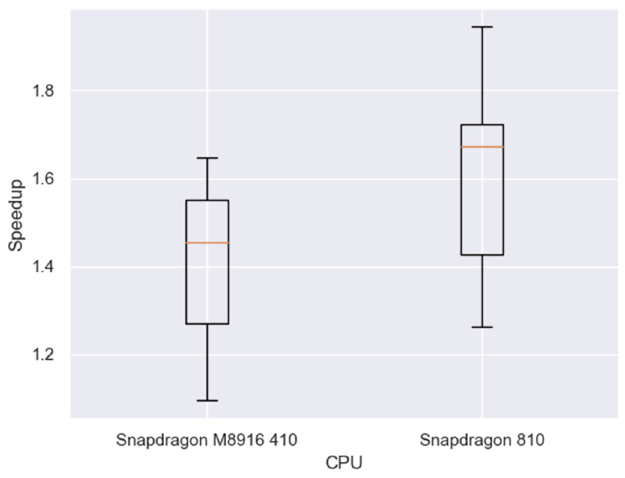
Figure 17. The speedup produced by different numbers of CPU cores.